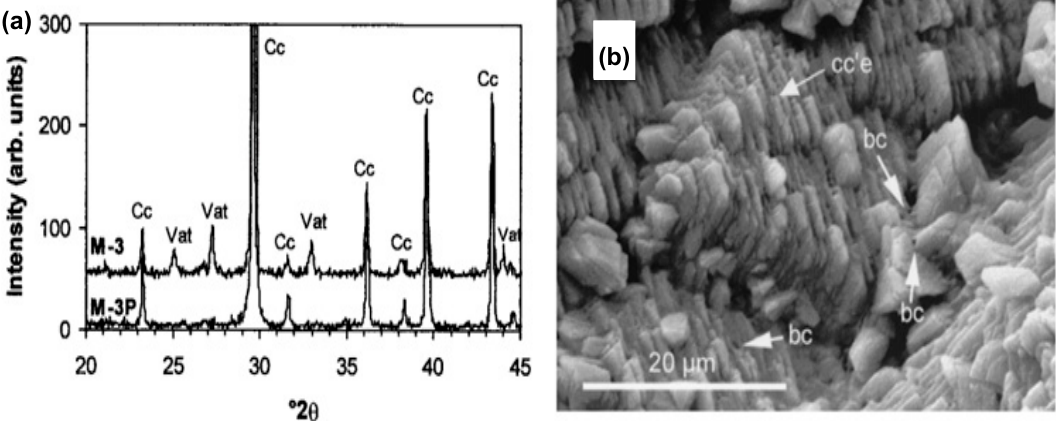
Figure 4. ( a ) XDR patterns of slabs subjected to microbiologically induced carbonate precipitation (MICP); ( b ) formed calcite crystals, developing epitaxially (cc’e) on pre-existing calcite crystals and showing preferred crystallographic orientation. Adapted with permission from [71] 2003, American Society for Microbiology.